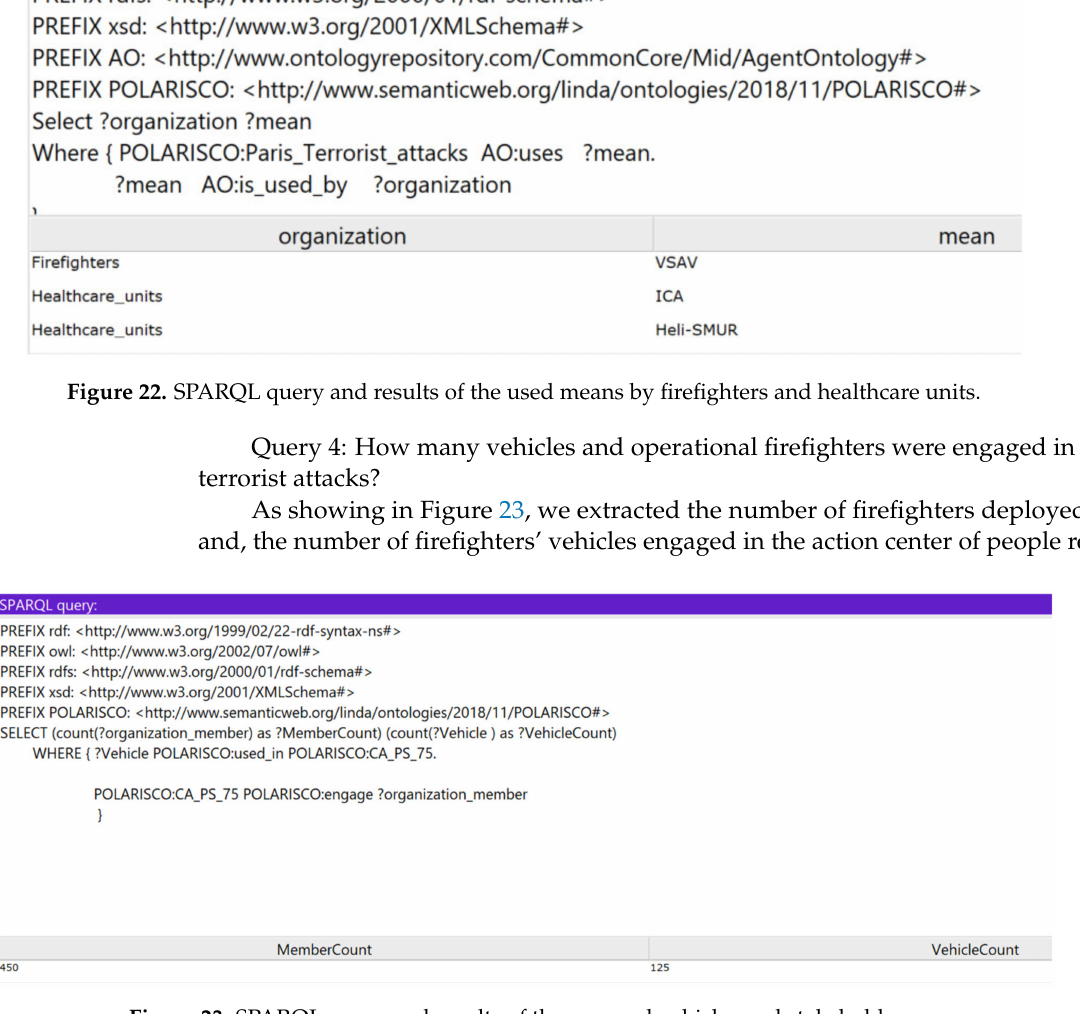
Figure 23. SPARQL query and results of the engaged vehicles and